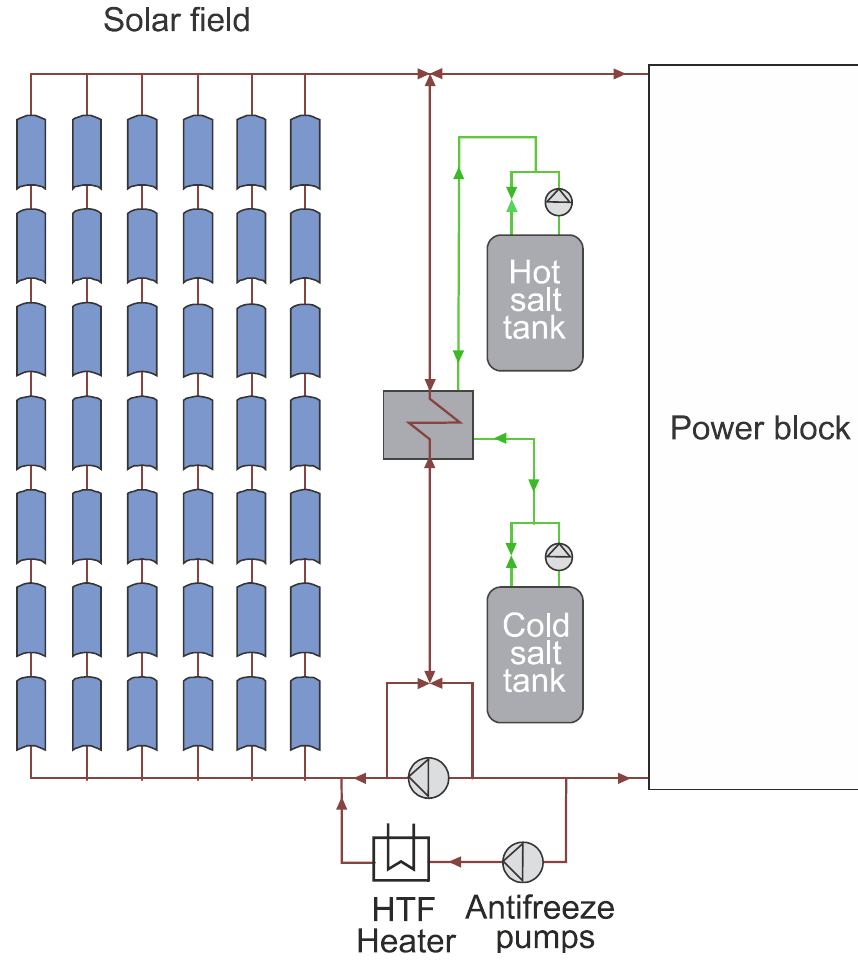
Figure 1. Parabolic trough power plant with thermal storage system.